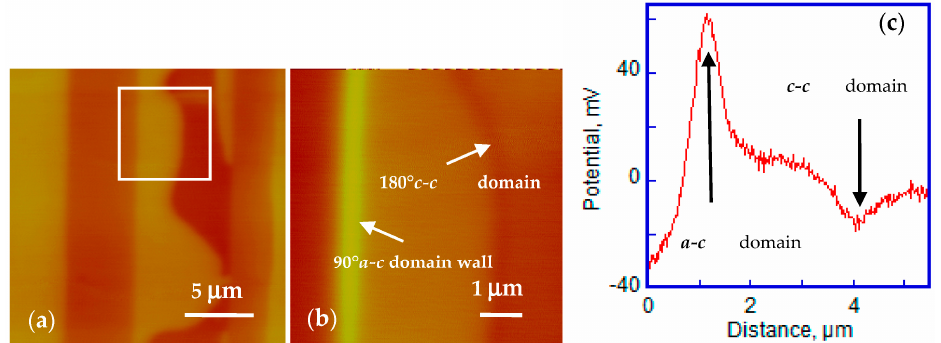
Figure 4. ( a ) Topography map of large-scale a-c domain structure. The square marked in the image is the zoom-in area used for domain wall potential barrier observation. ( b ) Surface potential image of the zoom in area acquired after cooling showing high broad potential barriers around a-c domain and c-c domain wall. ( c ) The surface potential cross section profile showing the width and height of the potential barriers.